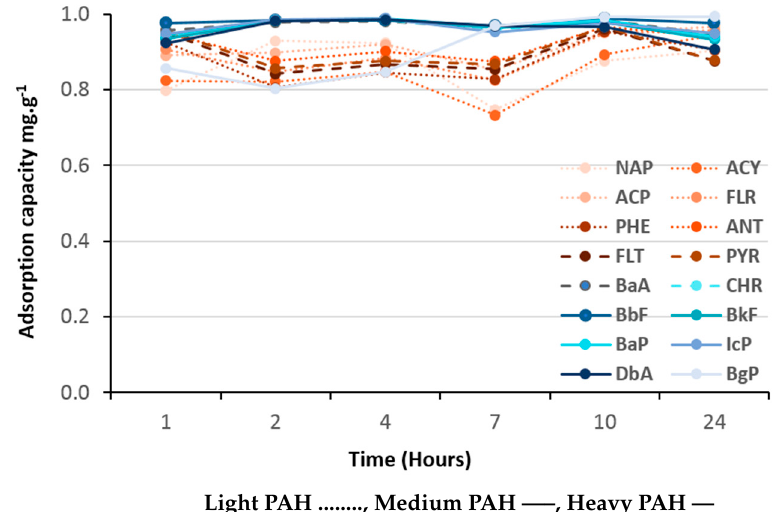
Figure 11. Adsorption kinetics of 16 PAHs on (TiO 2 ) 100 (HQPA).